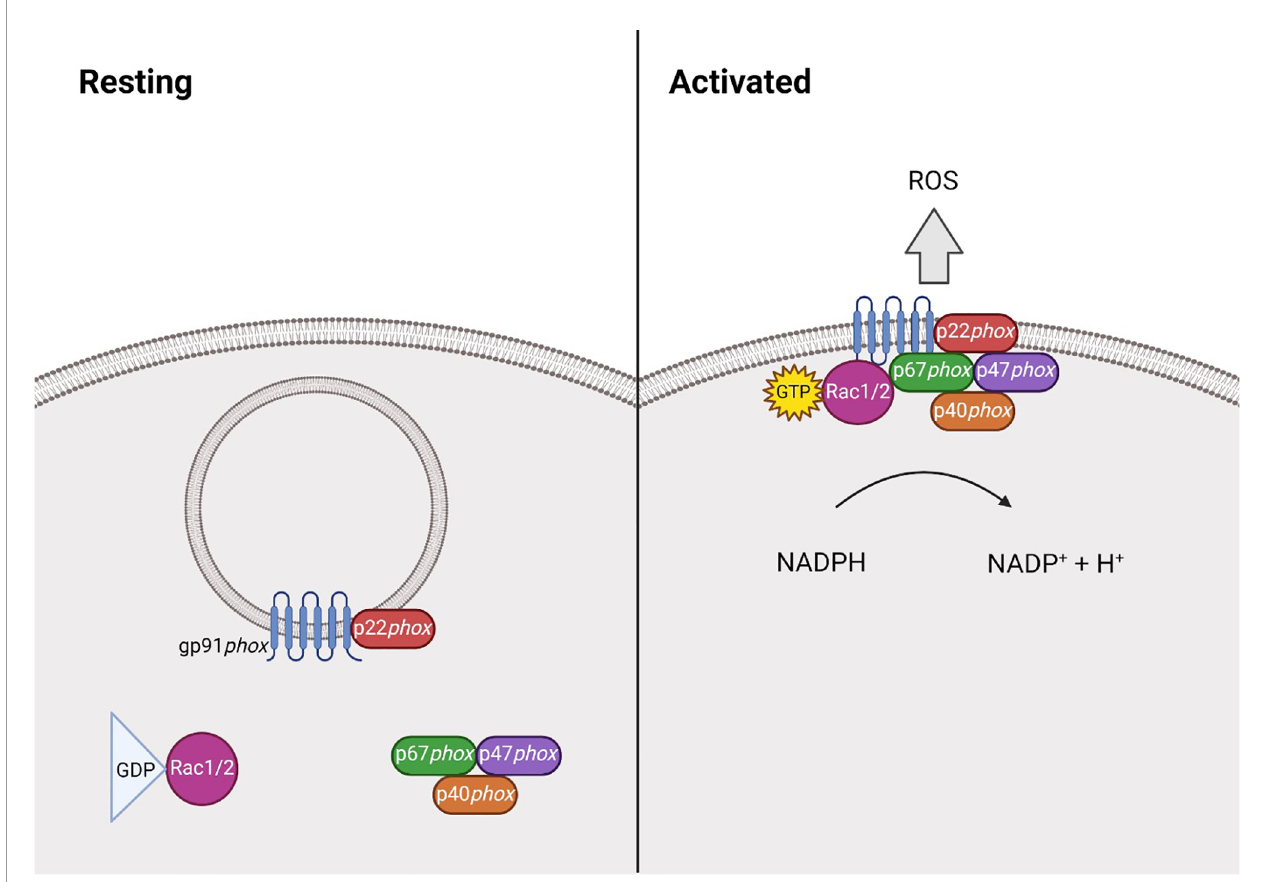
FIGURE 1 | Structure of NADPH oxidase 2 during resting and activated states. At rest NADPH oxidase 2 (NOX2) is comprised of the membrane bound heterodimer gp91 phox- p22 phox , and the cytosolic component, comprised of p40 phox (24), p47 phox (22), p67 phox (22) and the GTPase Rac1 (25) or Rac2 (26). Following stimulation, p47 phox becomes phosphorylated and the Rac protein becomes GTP-bound, allowing the complex to translocate to the membrane where it can associate with the gp91 phox -p22 phox heterodimer. Together, this forms the activated complex that generates reactive oxygen species (ROS) by transferring electrons from